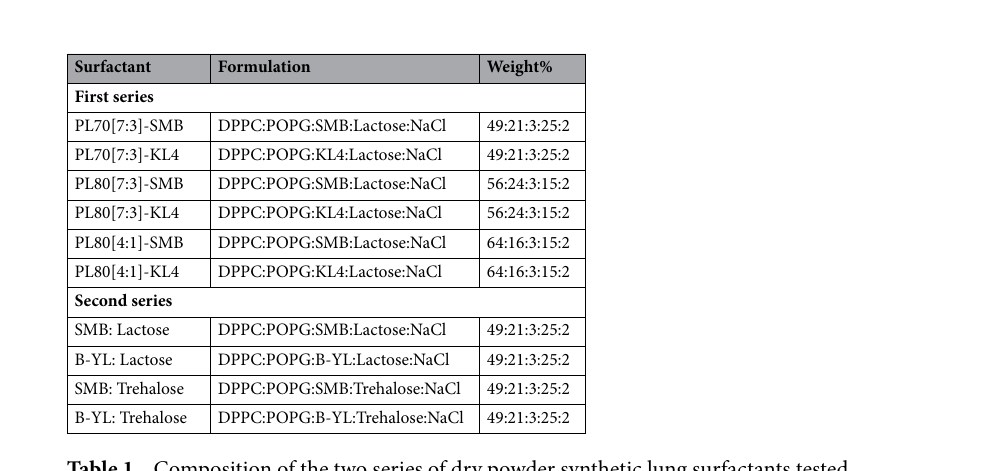
Table 1. Composition of the two series of dry powder synthetic lung surfactants tested.